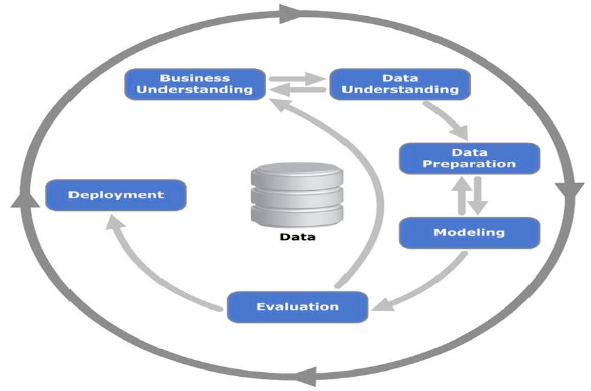
Figure 2. CRISP-DM methodology (Source: [26]).